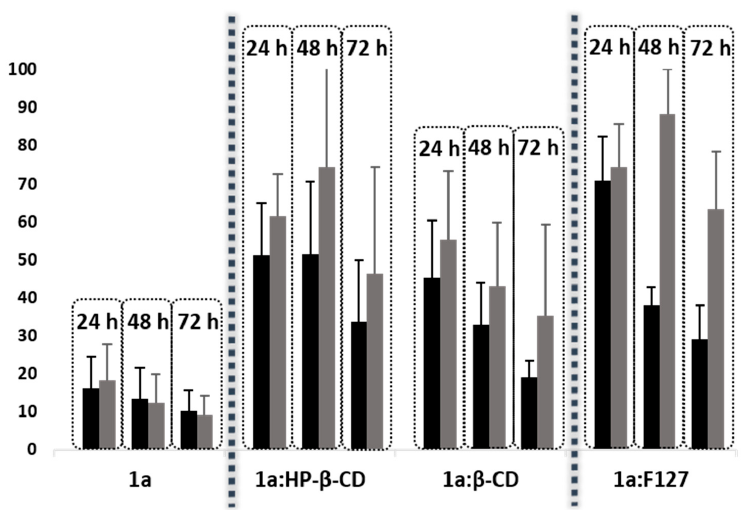
Figure 12. Cell growth of HT-29 cells treated with vehicle (DMSO) located adjacent to the cells treated with 50 (Control A, black) or 25 μ M (Control B, grey) of 1a , 1a :HP- β -CD, 1a : β -CD or 1a :F127 after 24, 48 and 72 h.